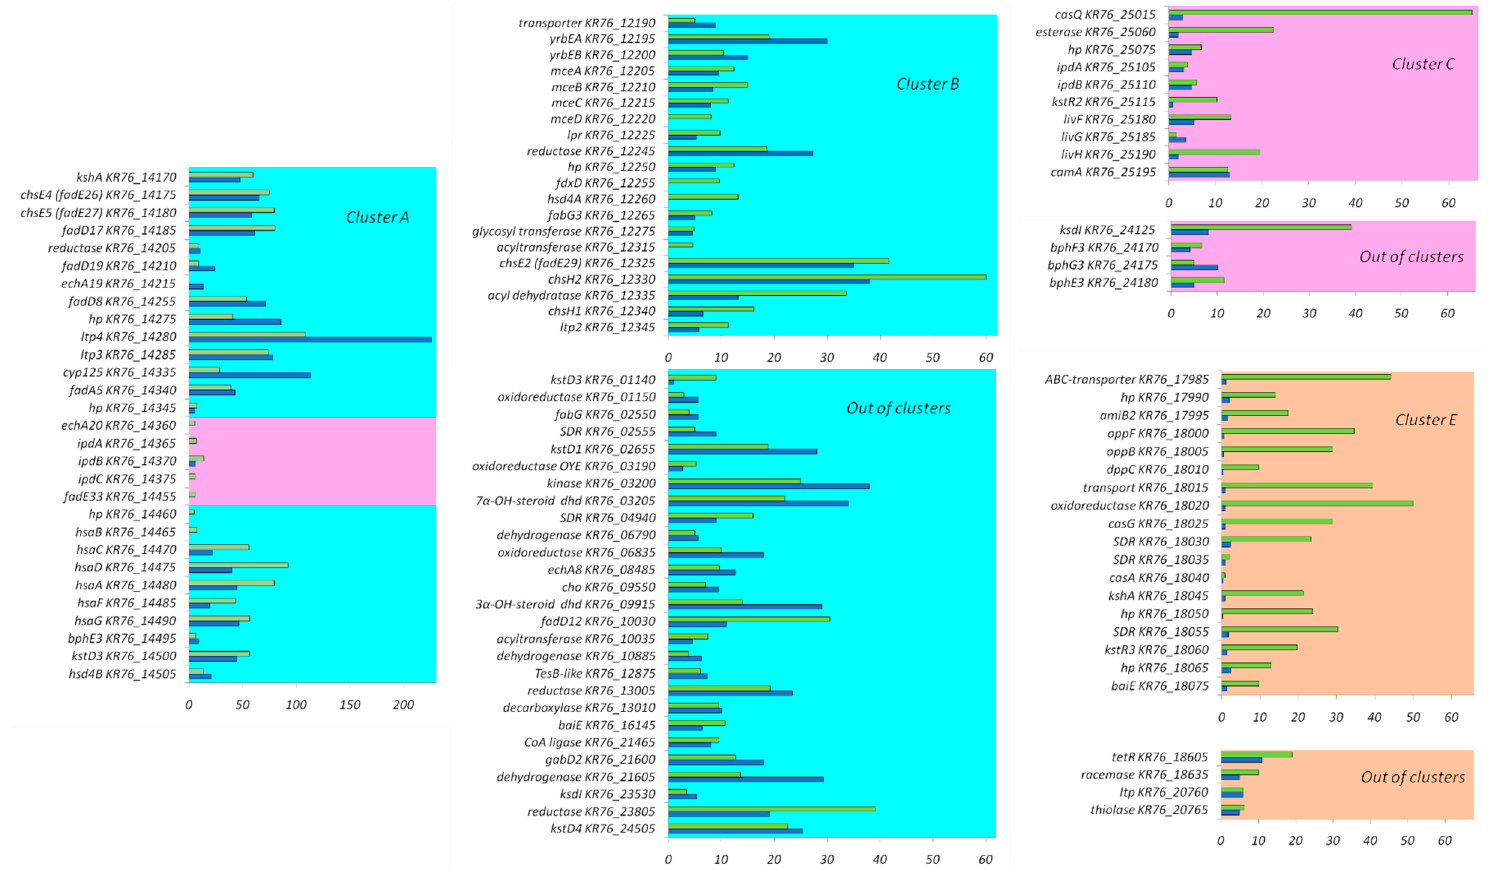
Figure 5. Differentially expressed genes in the N. simplex VKM Ac-2033D genome. Blue bars–expression induction by cholesterol (fold change), green bars–expression induction by LCA (fold change), light blue color–predicted KstR-regulon, pink–predicted KstR2-regulon, light orange–predicted Lcin1-regulon. Only genes that changed expression more than threefold with q -value less than 0.05 are shown. Abbreviations: hp–hypotetical protein, dhd–dehydrogenase, SDR–short-chain dehydrogenase-reductase. X-axis–expression changes (for cluster A the scale is expanded to 200).